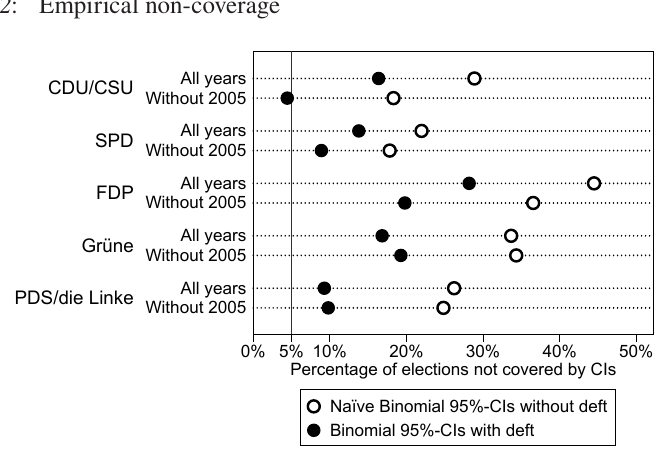
Figure 2 : Empirical